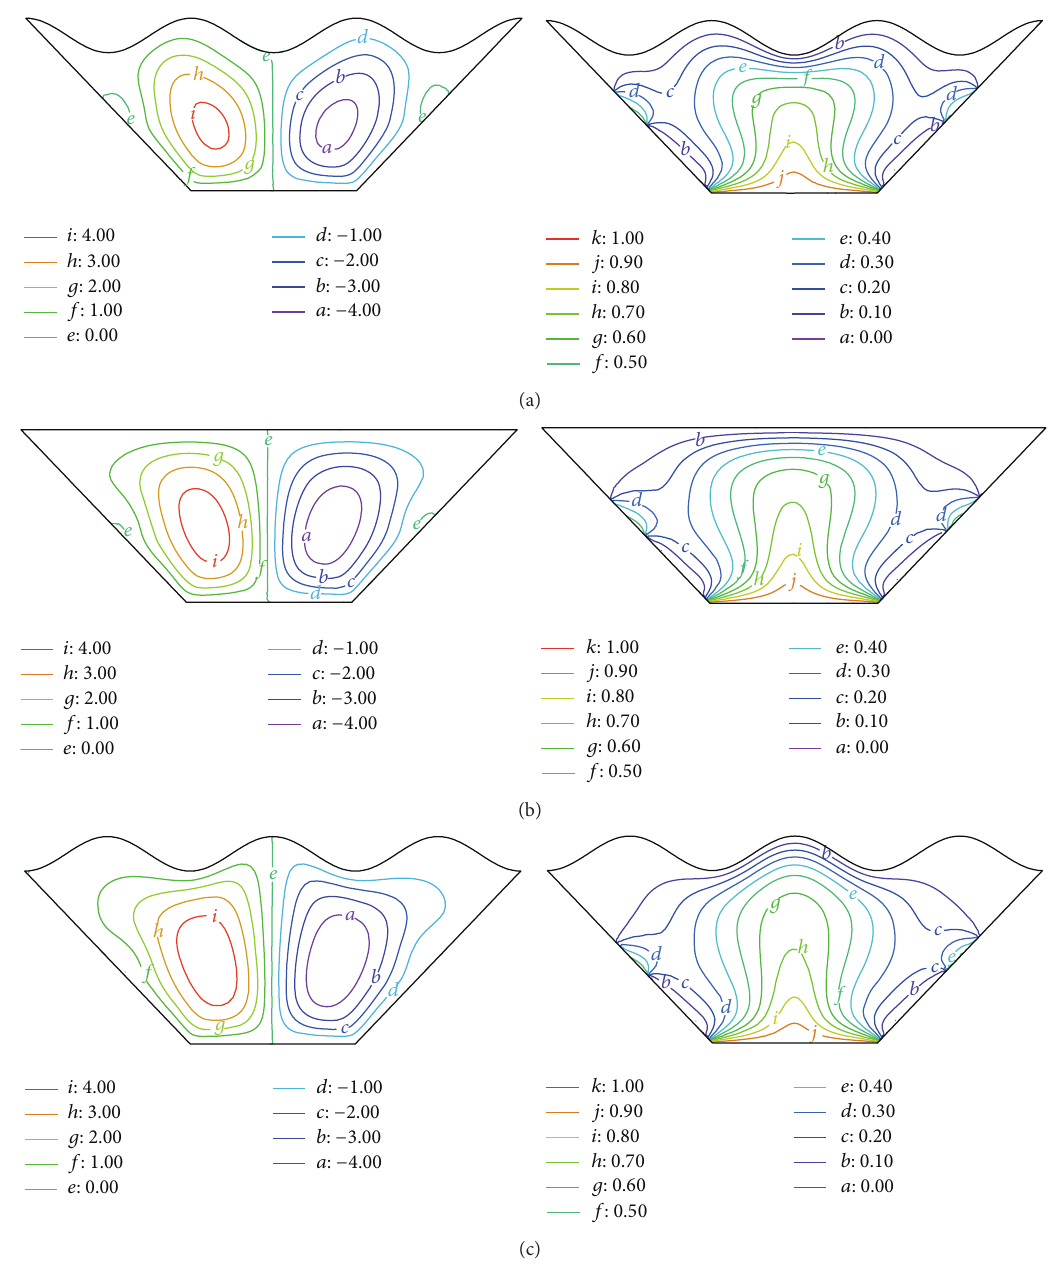
Figure 4: Streamlines (left) and isotherms (right) for Ra = 10 6 and Da = 10 −4 . (a) 𝑎 = 0.9 , (b) 𝑎 = 1 , and (c) 𝑎 = 1.1 .